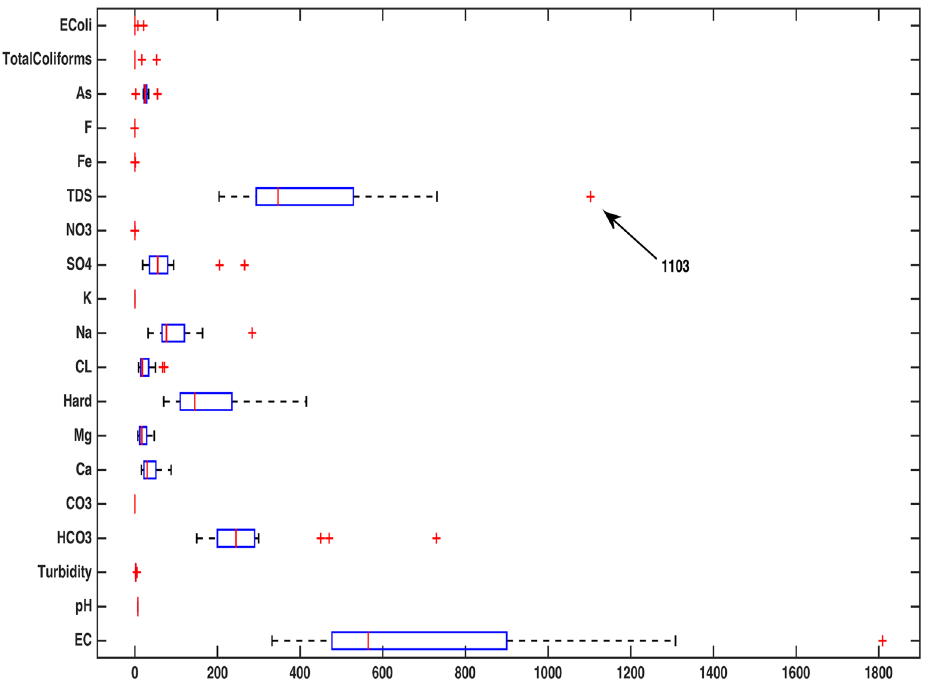
Figure 3. A boxplot showing water parameters’